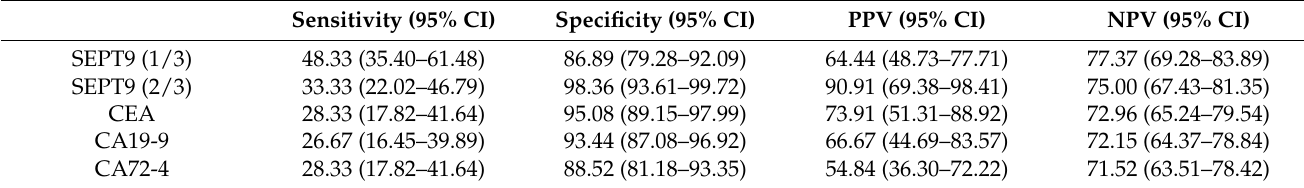
Table 2. Sensitivity, Specificity, PPV, and NPV of mSEPT9 and serum tumor markers.